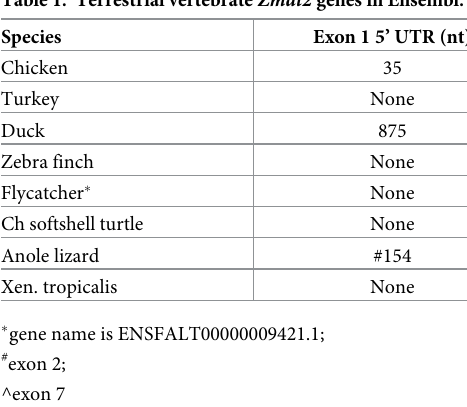
found in Zmat2 mRNAs in several different frog tissues (Fig 3C), even though orthologs of these exons were not detected in any other terrestrial vertebrate species. Moreover, of note, there is no cognate of exon 5 from other vertebrates in Xenopus tropicalis Zmat2 . Collectively, the different Zmat2 exons were transcribed and processed into 3 classes of mRNAs that encoded Xenopus ZMAT2 proteins of 172, 197, and 198 amino acids (Fig 3D and 3E). Thus, Xenopus tropicalis Zmat2 appears to be the outlier among terrestrial vertebrates.